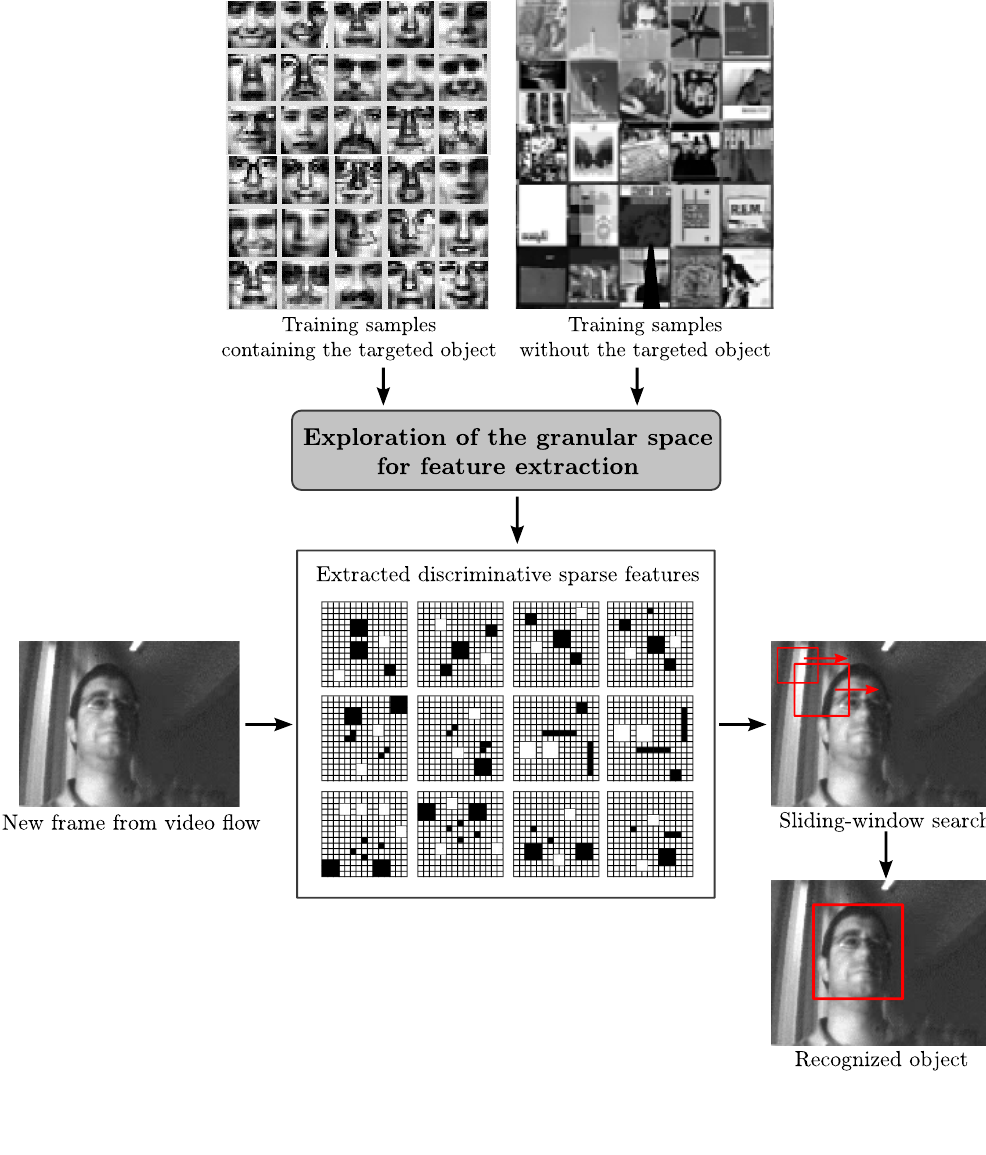
Figure 14. Object recognition pipeline based on the granular space. The white and black granules are respectively weighted positively and negatively when it comes to attaining a representative value of the corresponding sparse